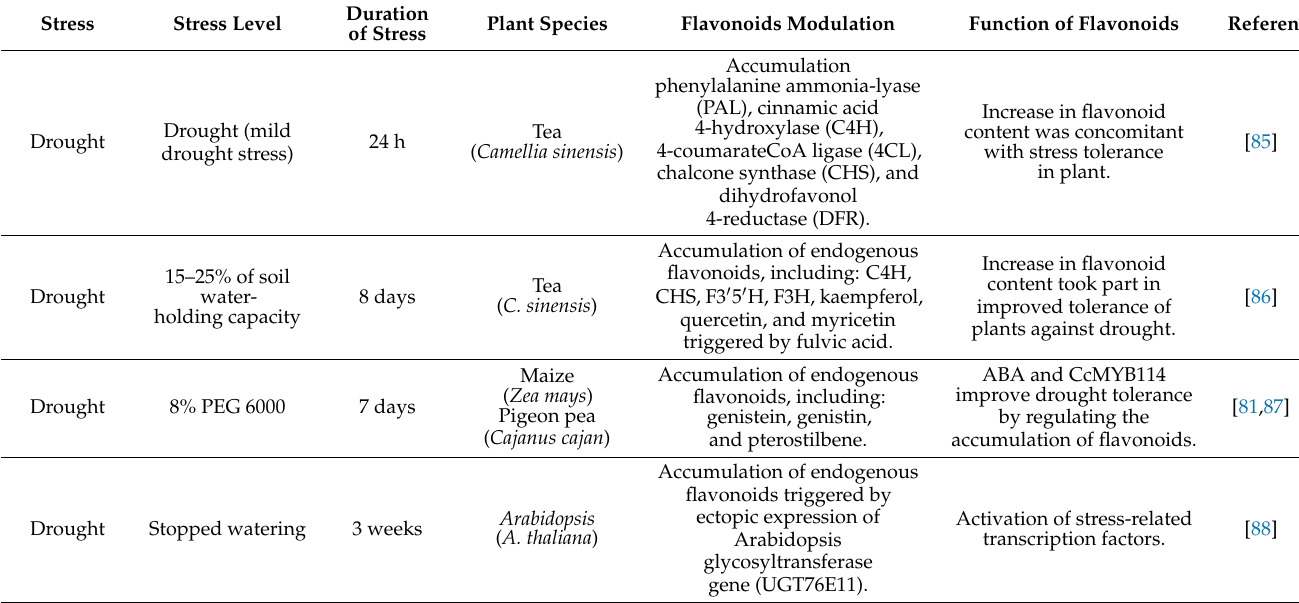
Table 3. Functional role of flavonoids in plants’ response to abiotic